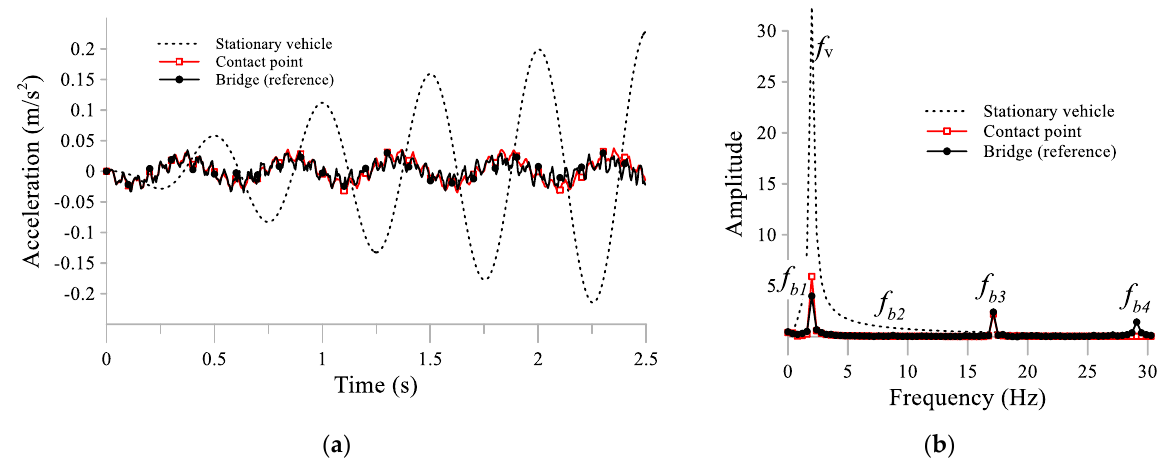
Figure 6. Dynamic response of the stationary vehicle at 1.95 Hz, along with its contact-point and bridge ( a ) acceleration responses at the mid-span location and ( b ) the acceleration spectra.